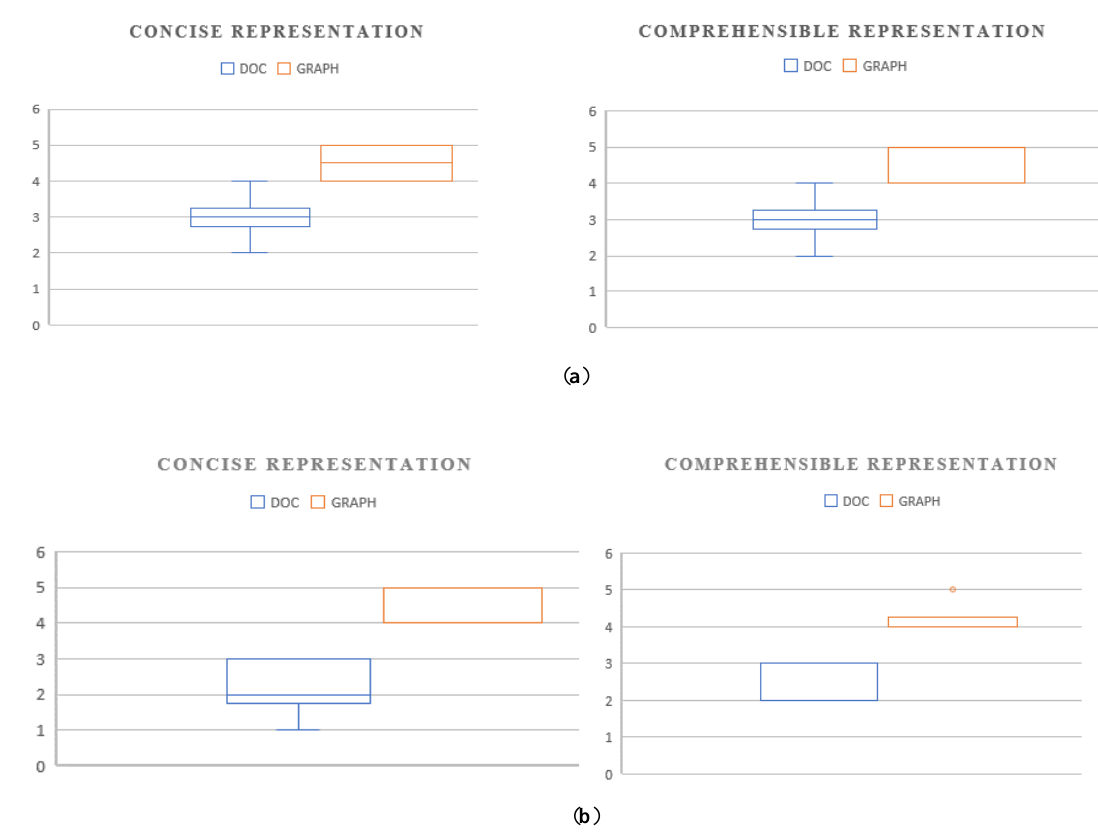
Figure 9. Show Box plot of the concise and comprehensible representations by Doc and Graph with the Likert scale 1–5. ( a ) Diabetes and Kidney Disease Group. ( b ) Heart and Artery Disease Group.